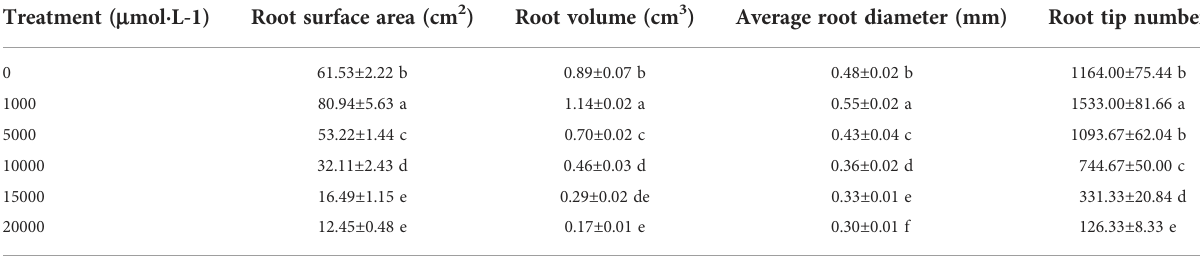
TABLE 2 Effects of manganese stress on root characteristics of D. carota.